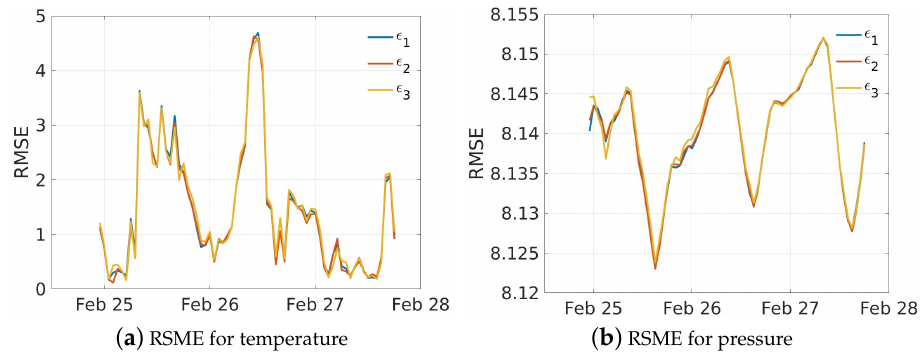
Figure 8. RMSE over time for surface temperature and pressure variables under each perturbation type, computed using observational data from SIATA. The RMSE values for temperature and pressure are illustrated in subfigures ( a , b ),